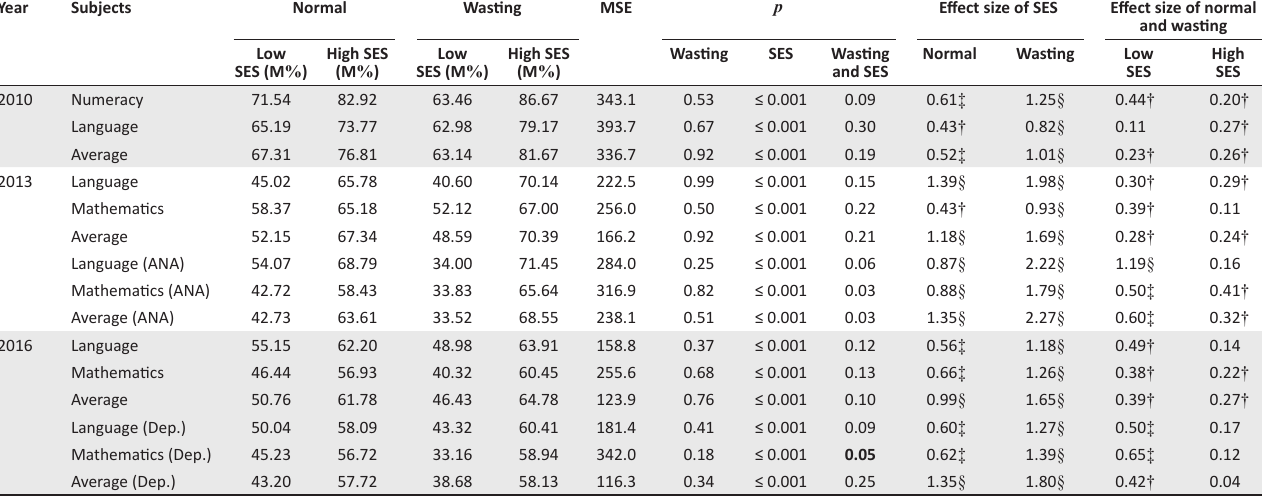
TABLE 5: Meaningful differences between normal weight, wasting and academic subjects per